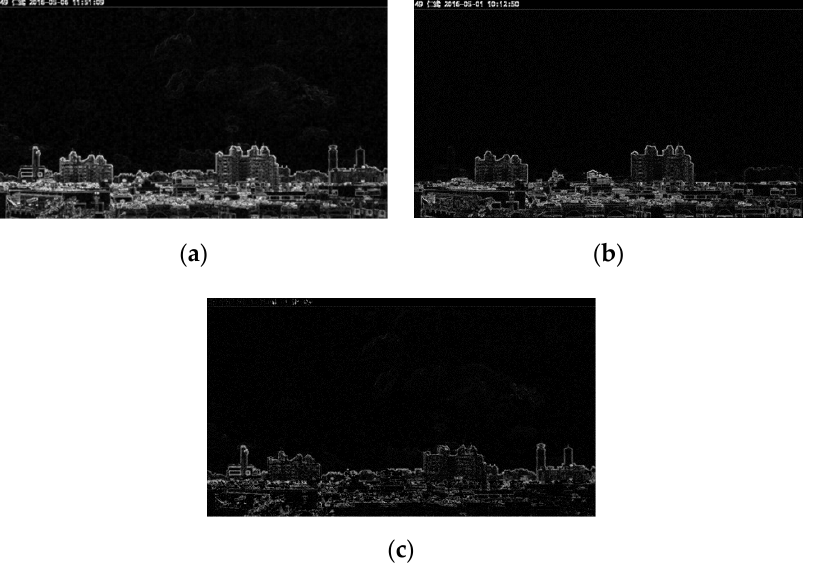
Figure 4. Images after Sobel edge detection. ( a ) I 1,s (low PM 2.5 concentration); ( b ) I 2,s (high PM 2.5 concentration); ( c ) the difference of ( a ) and ( b ).